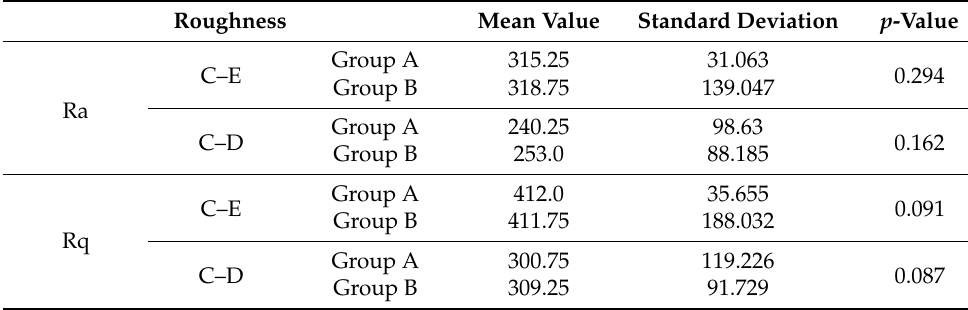
Table 3. Roughness values for the Group B sample.